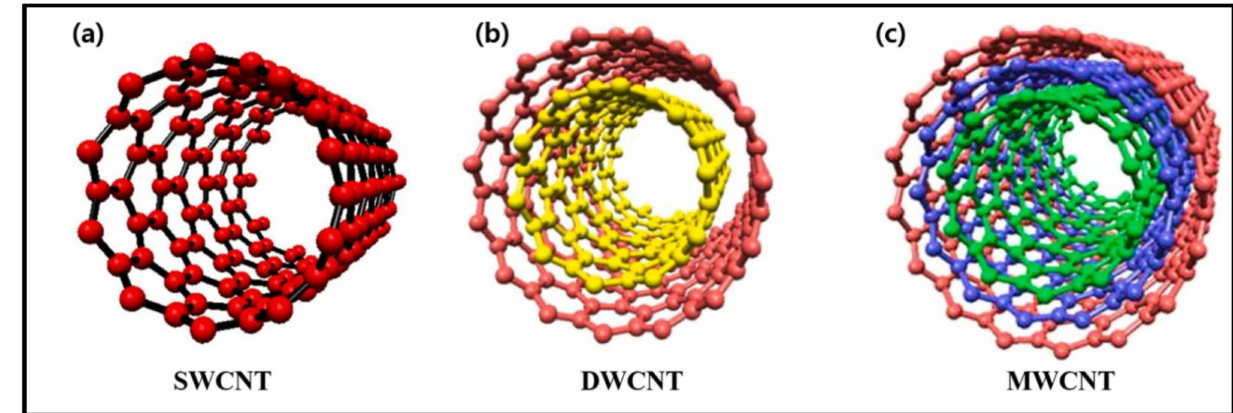
Figure 2. Surface and internal view of ( a ) single-walled CNTs, ( b ) double-walled CNTs, and ( c ) multi-walled CNTs